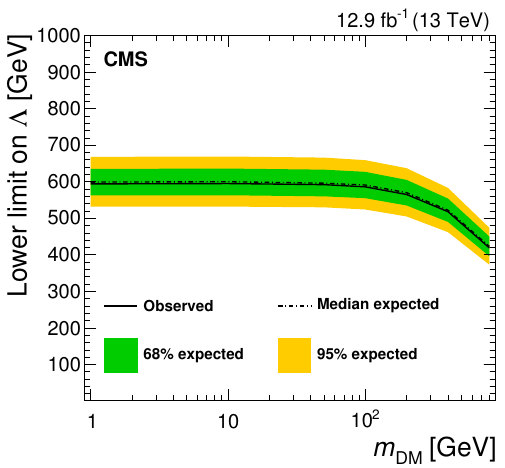
Figure 4 . The 90% CL exclusion limits on the (cid:31) -nucleon spin-independent (left) and spin- dependent (right) scattering cross sections involving vector and axial-vector operators, respectively, as a function of the m DM . Simpli(cid:12)ed model DM parameters of g q = 0 : 25 and g DM = 1 are assumed. The region to the upper left of the contour is excluded. On the plots, the median expected 90% CL curve overlaps the observed 90% CL curve. Also shown are corresponding exclusion contours, where regions above the curves are excluded, from the recent results by CDMSLite [39], LUX [40], Pan- daX [41], CRESST-II [42], PICO-60 [43], IceCube [44], PICASSO [45] and Super-Kamiokande [46] Collaborations.